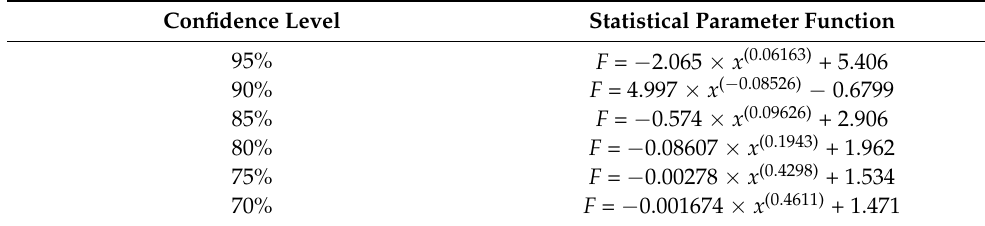
Table 1. Statistical parameter function under different confidence